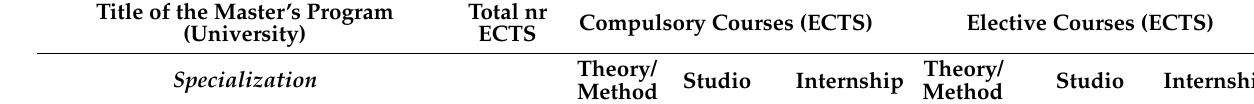
Table 3. Compulsory and elective courses on participatory, collaborative, and transdisciplinary design in the master’s programs. Title of the Master’s Program